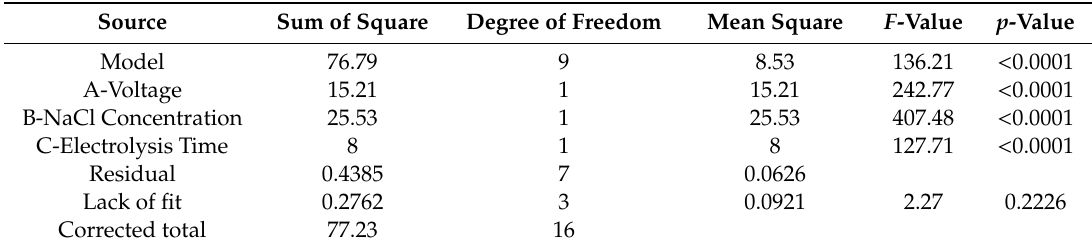
Table 11. Analysis of variance for the developed response surface quadratic model for pH of AlEW.